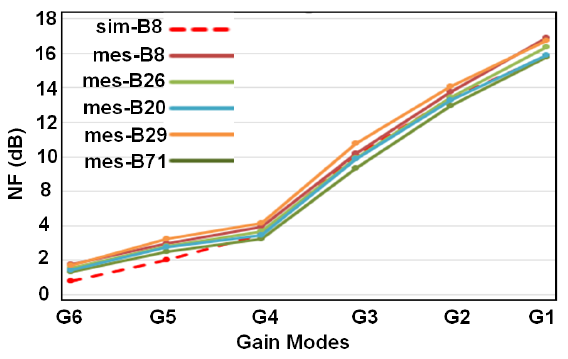
Figure 8. Simulated and measured noise figure for different